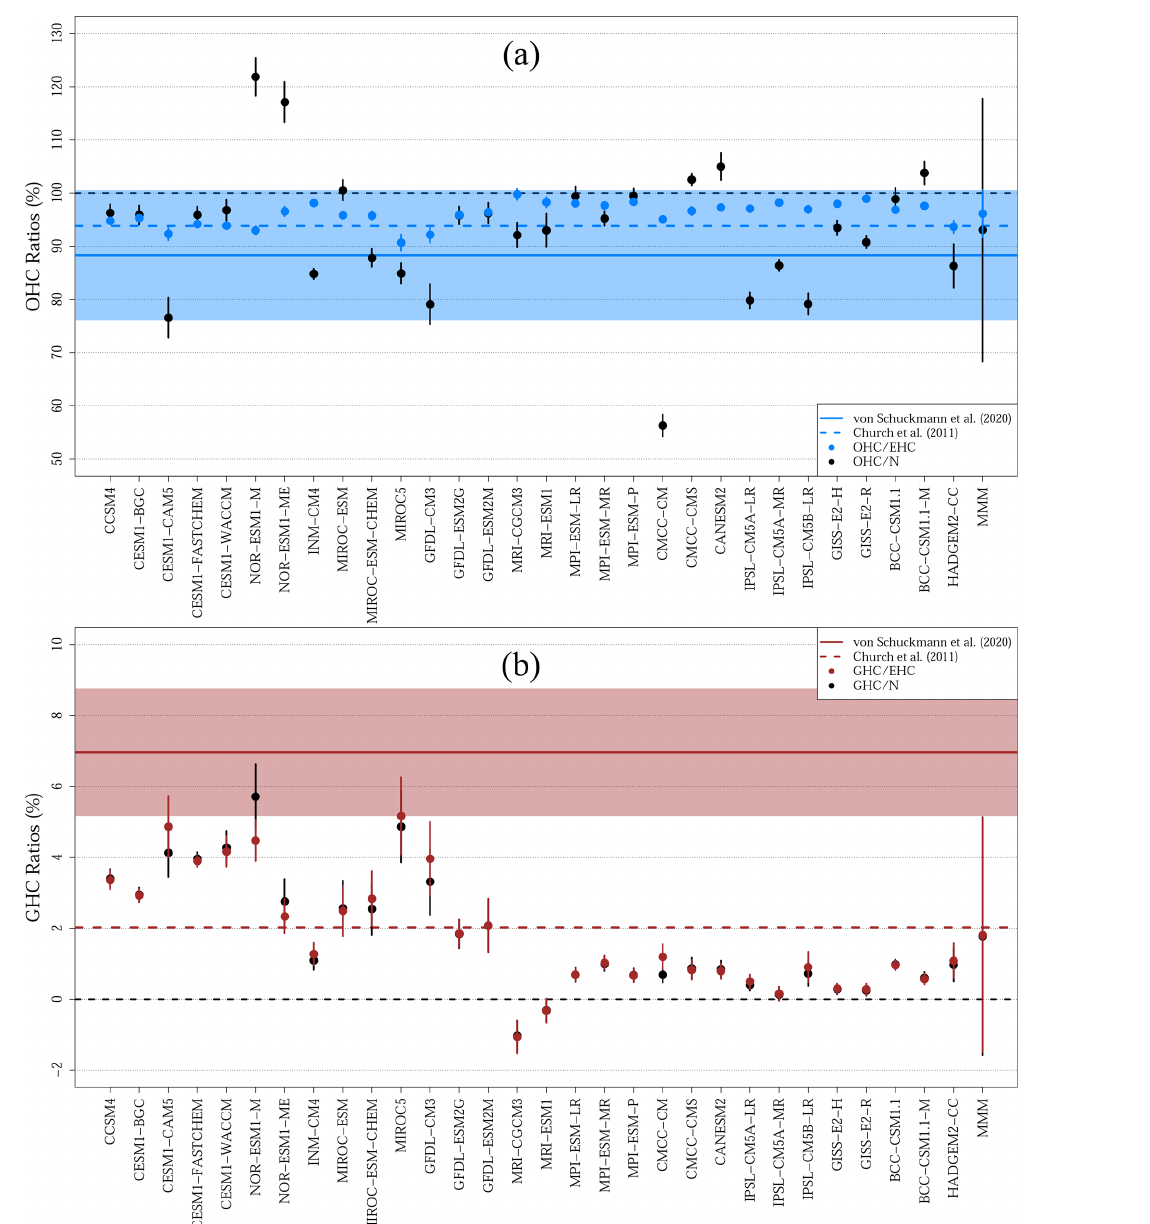
Figure 4. (a) Simulated proportion of heat within the ocean for the period 1972–2005CE using EHC (blue dots) and N (black dots) as estimates of total heat content in the climate system. (b) Simulated proportion of heat within the continental subsurface for the period 1972– 2005CE using EHC (red dots) and N (black dots) as estimates of total heat content in the climate system. Observations from von Schuckmann et al. (2020) are shown as solid horizontal lines and shadows (means and 95% confidence intervals), and observations from Church et al. (2011) are displayed as dashed horizontal lines. Multimodel means and 95% confidence intervals are indicated in the right side of the panels (MMM). Black dashed lines indicate the 0% and 100%